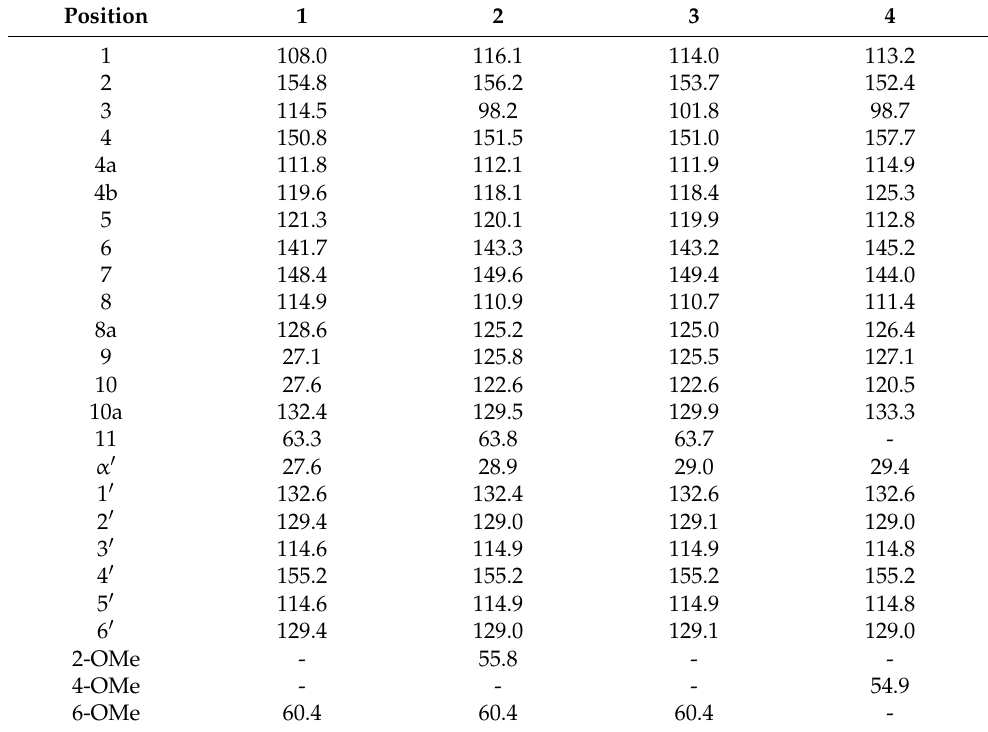
Table 2. 13 C (75 MHz) NMR data of compounds 1 – 4 in acetone- d 6